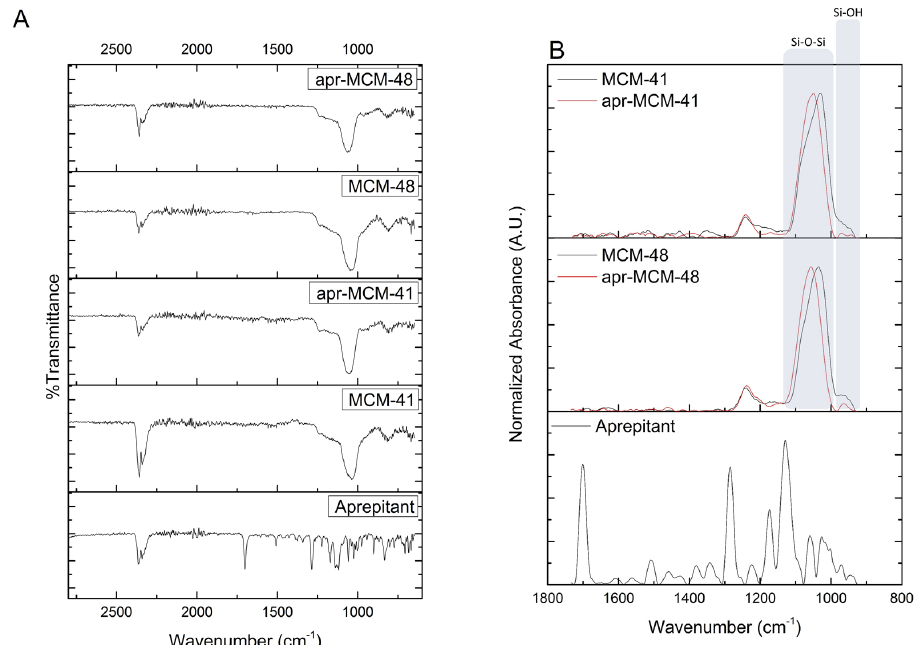
Figure 7. ( A ) Attenuated Total Reflectance Fourier Transform Infrared Spectroscopy (ATR-FTIR) analysis of the pristine and drug-loaded MSN particles. ( B ) Normalized absorbance ATR-FTIR spectra focused on the region between 800–1800 cm − 1 .